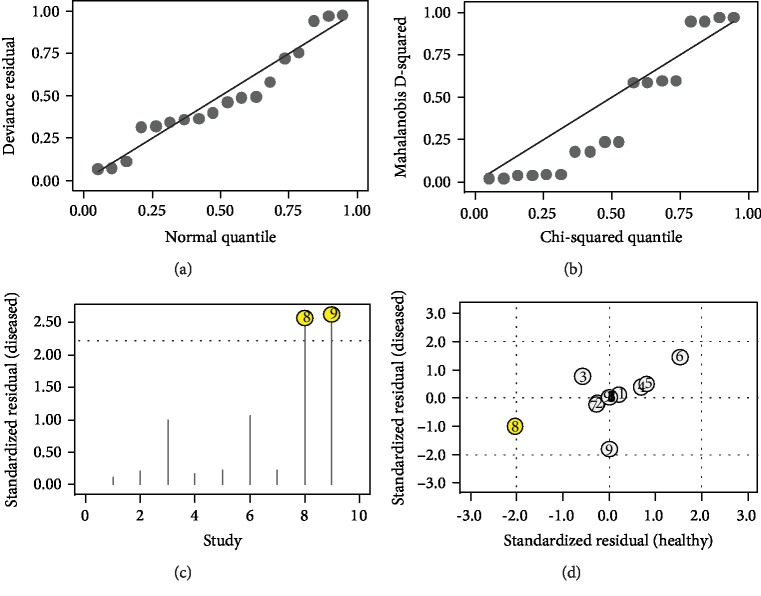
Influence analysis and outlier detection: (a) goodness of fit, (b) bivariate normality, (c) influence analysis, and (d) outlier detection.